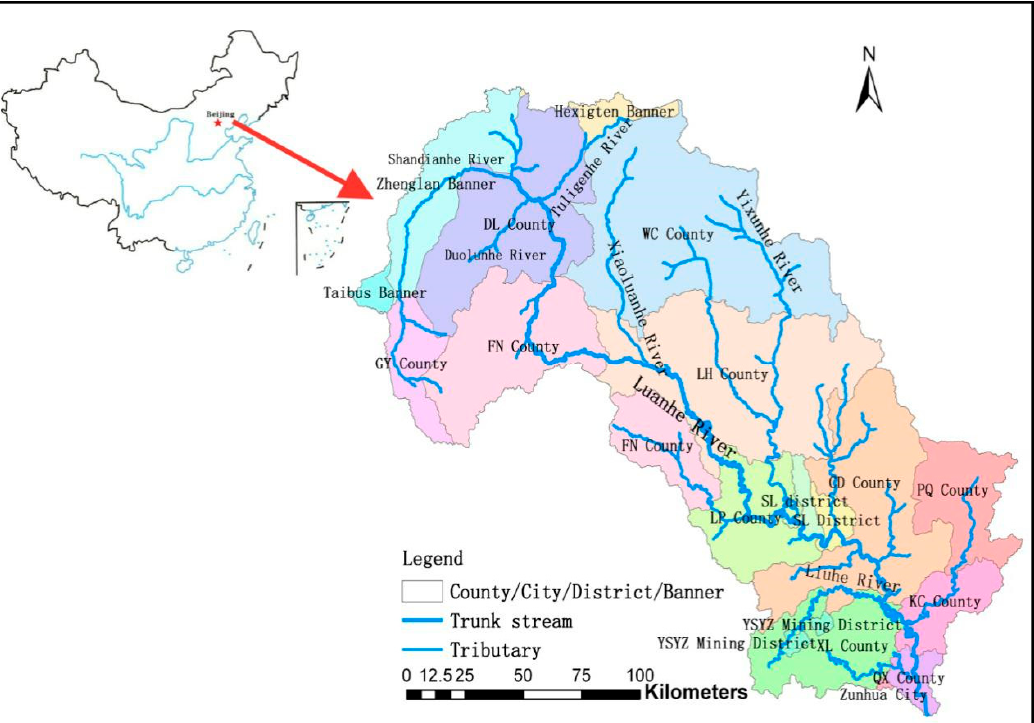
Figure 1. Upper-middle reaches in the Luanhe River.